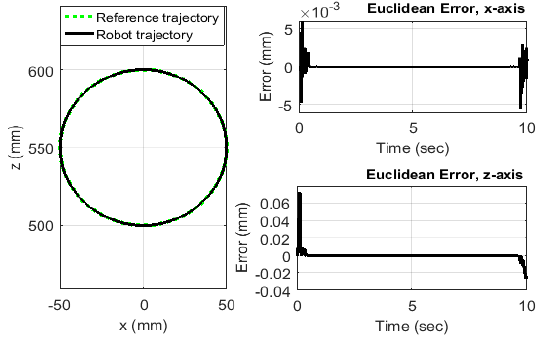
Figure 9. The angular velocity with the dynamic